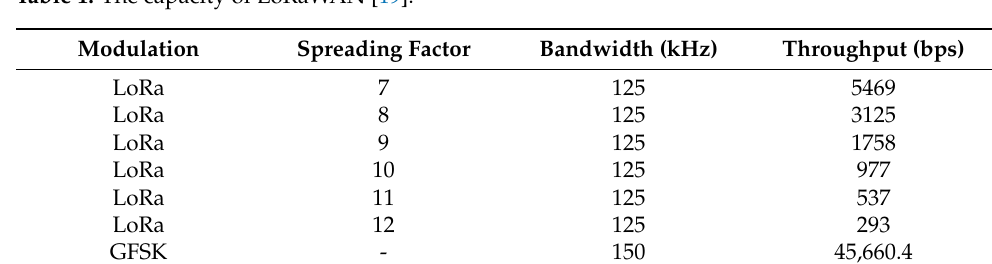
Table 1. The capacity of LoRaWAN [19].